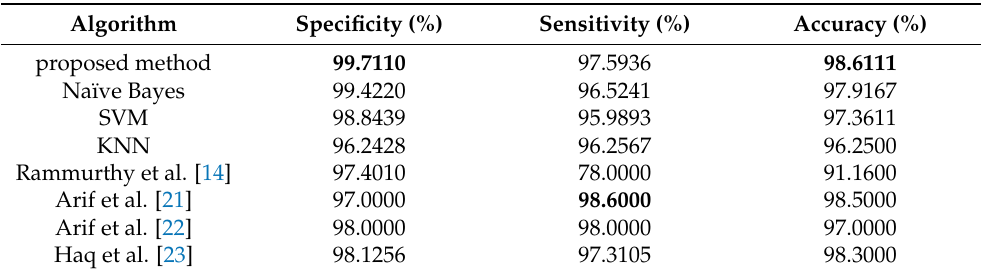
Table 4. Comparison of the proposed method with previous works in diagnosis of brain tumors in BRATS2014